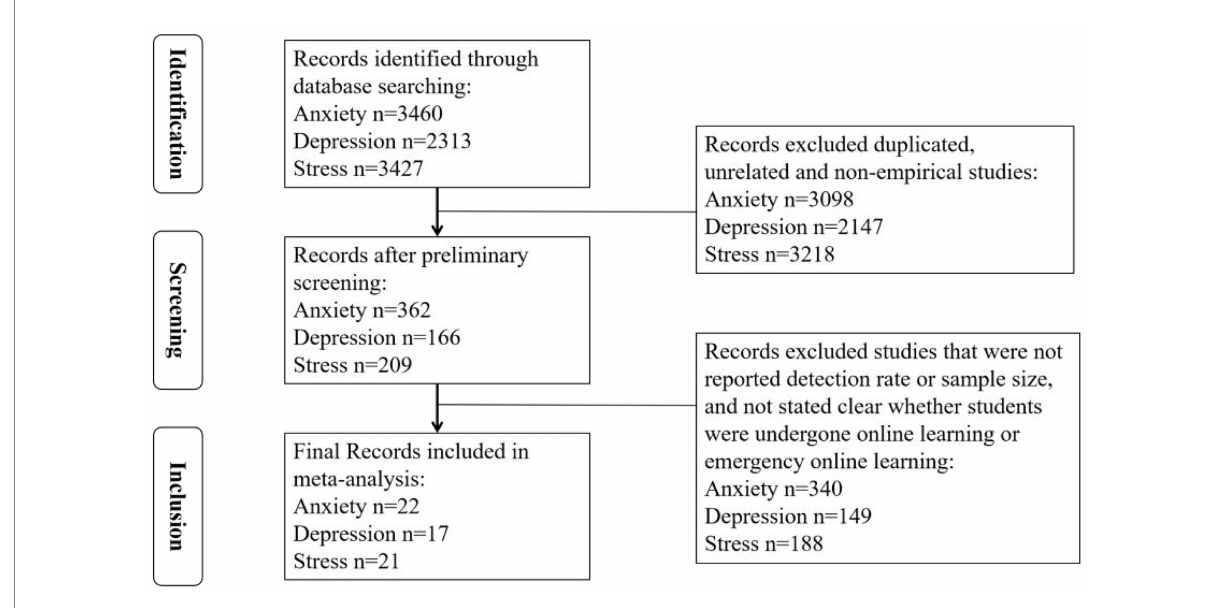
FIGURE 1 A flow diagram of literature searching and